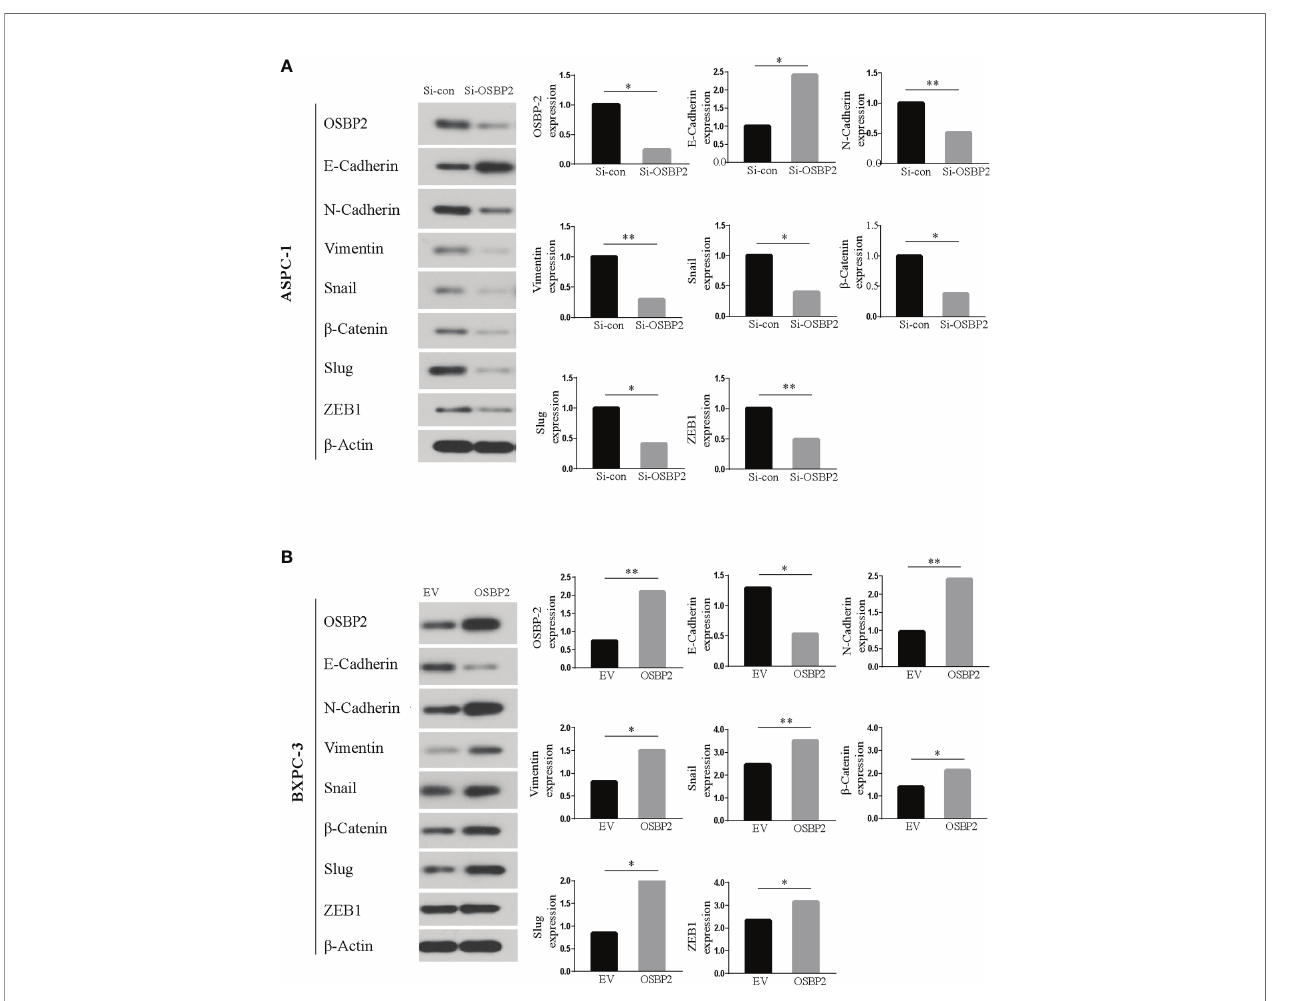
FIGURE 8 | Western blot. (A) Western blot analysis revealed upregulated E-cadherin and downregulated N-cadherin, vimentin, and Snail expression in OSBP2-knockdown ASPC-1 cells. (B) Western blot analysis revealed upregulated N-cadherin, vimentin, and Snail and downregulated E-cadherin expression following overexpression of OSBP2 in BXPC-3 cells. OSBP2, Oxysterol-binding protein 2. *P < 0.05, **P <